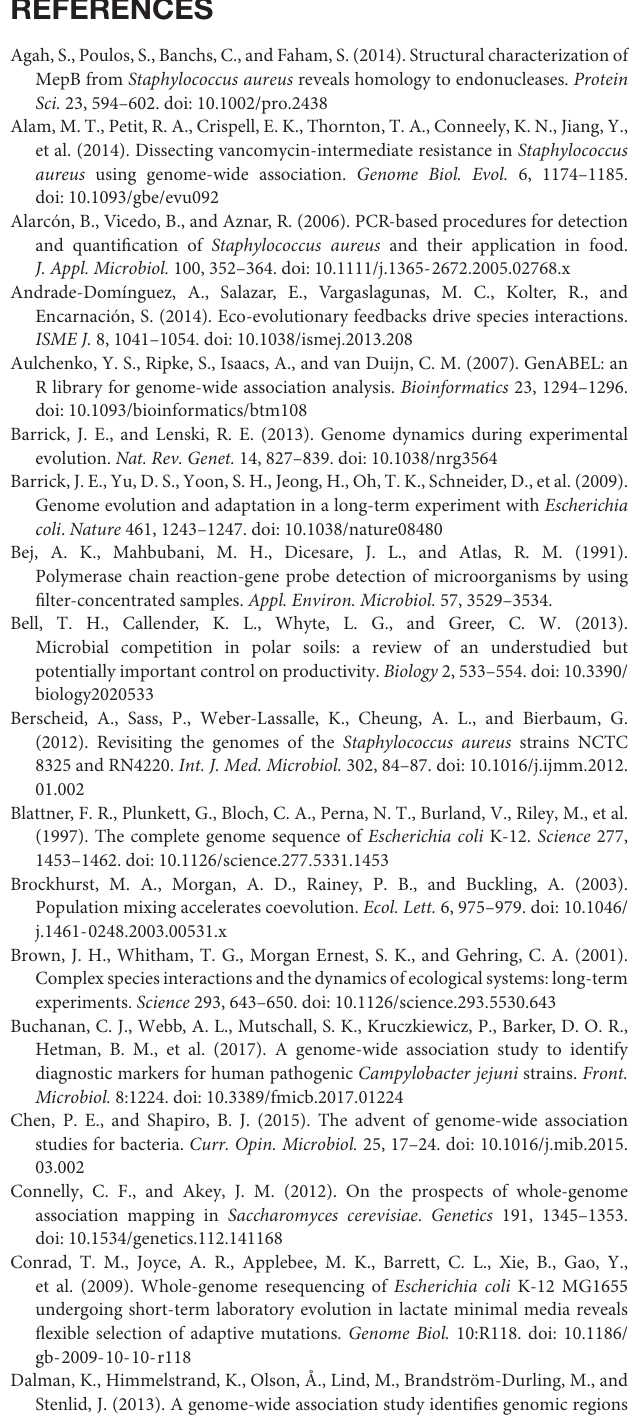
TABLE S7 | Indels associated with growth